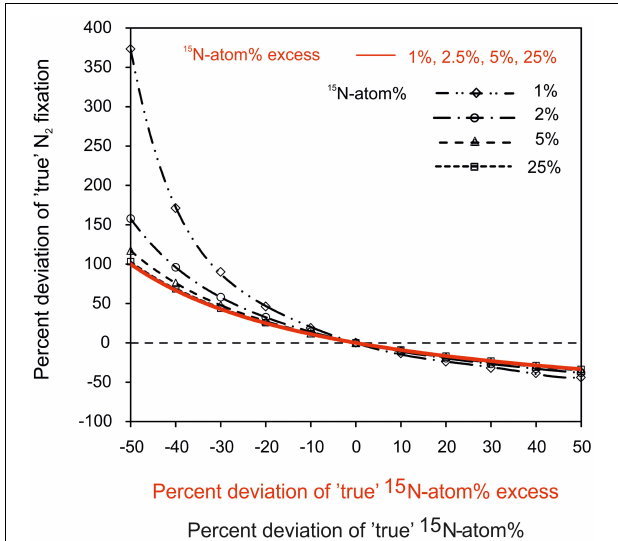
FIGURE 5 | Modeled deviation from true , actual N 2 fixation rates in correlation to the potential deviation from true values of 15 N-atom% (in black) or 15 N-atom% excess (in red). Following Equation 2, a deviation of 15 N-atom% or 15 N-atom% excess from the true value will lead to significant under- or overestimations of N 2 fixation. This error in N 2 fixation rates is especially pronounced when the 15 N-atom% or 15 N-atom% excess is underestimated. In addition, the variable 15 N-atom% is corrected for the naturally present 15 N (0.366%) for calculations of N 2 fixation rates. This correction has a more pronounced weighting on the calculated N 2 fixation when using a low 15 N-atom% of ≤ 2% compared to a higher 15 N-atom of ≥ 5%. The percent deviation was calculated as difference between the incorrect , i.e., falsely estimated value of 15 N-atom%/ 15 N-atom% excess and their true